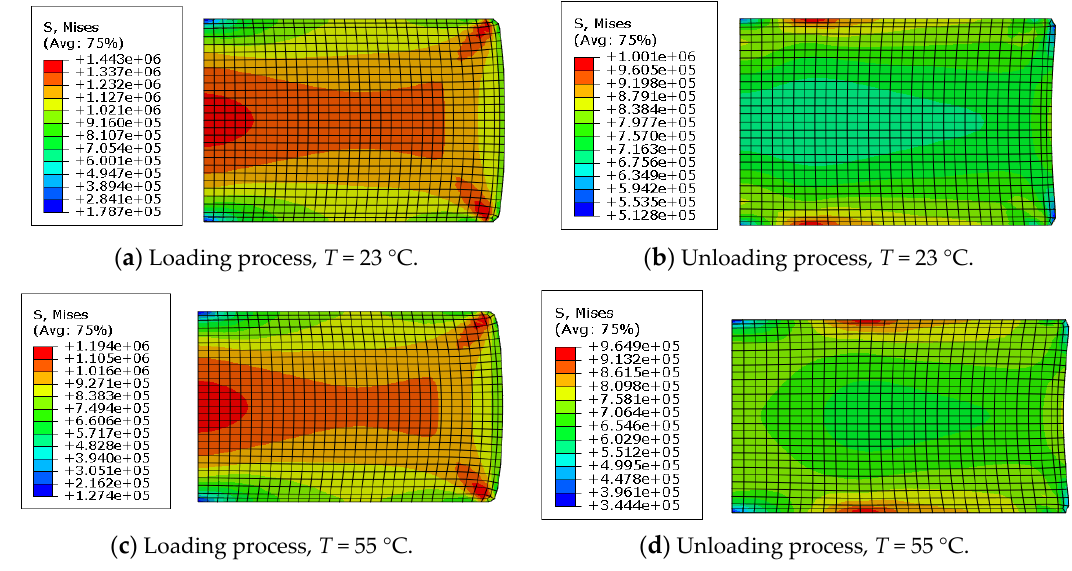
Figure 10. Stress distribution profile at strain of 16%.